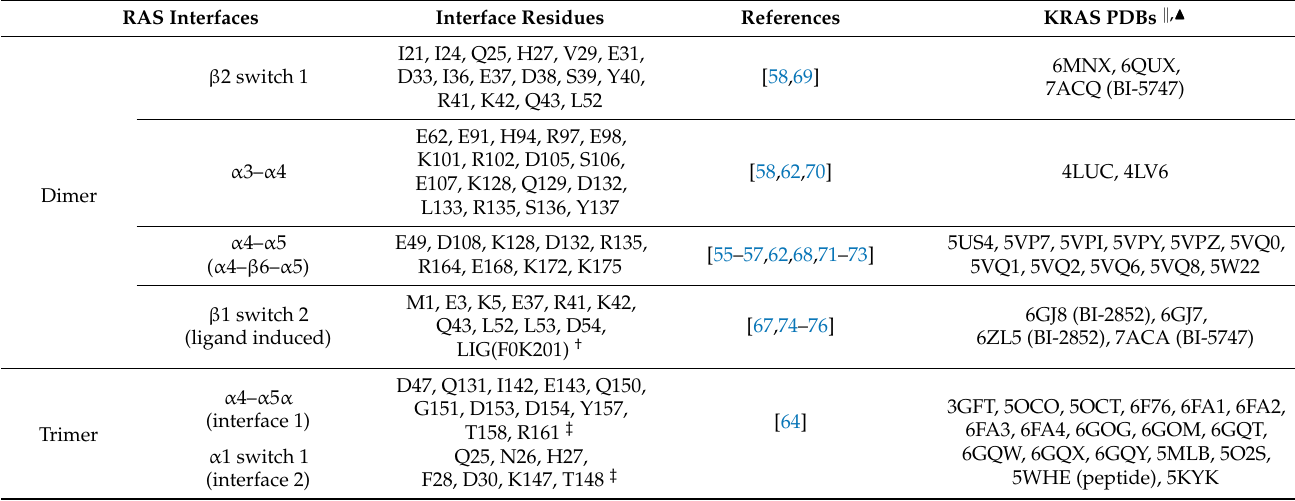
Table 1. RAS interfaces and key residues. RAS–RAS interfaces discussed in the literature and from crystallographic analysis of KRAS interfaces from the PDB. To identify KRAS interfaces, we evaluated 154 PDB files. Specifically, for each PDB file, interfaces between chains were identified by calculating distances between every pair of sidechains. The interfaces along with the sidechains were written as a text file, and PDB files containing only the two chains with interfaces were written out for visualization. We clustered interfaces by representing the interface as a bit string (where 1 indicates that the sidechain is part of the interface, and 0 indicates that it is not) and by calculating the Tanimoto Coefficient. Some PDB codes were added to the table, like 6GJ8, that were not found by the automated procedure. Python scripts are available on